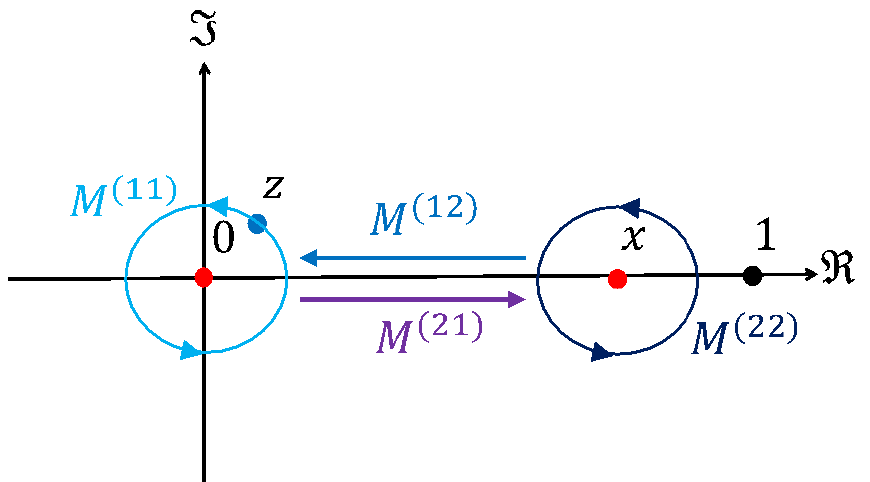
Figure 2 . To obtain the monodromy matrix, we have to evaluate the monodromy around z = x , while excluding z = 1. However, as long as we are restricted to the solution of the ODE (3.2), we cannot distinguish the points z = f x; 1 g . Therefore, we have to see the solution to the ODE in another limit 1 (cid:0) x (cid:28) 1 with z (cid:0) x (cid:29) 1, which is shown in (3.7). The matrices displayed in 1 (cid:0) x